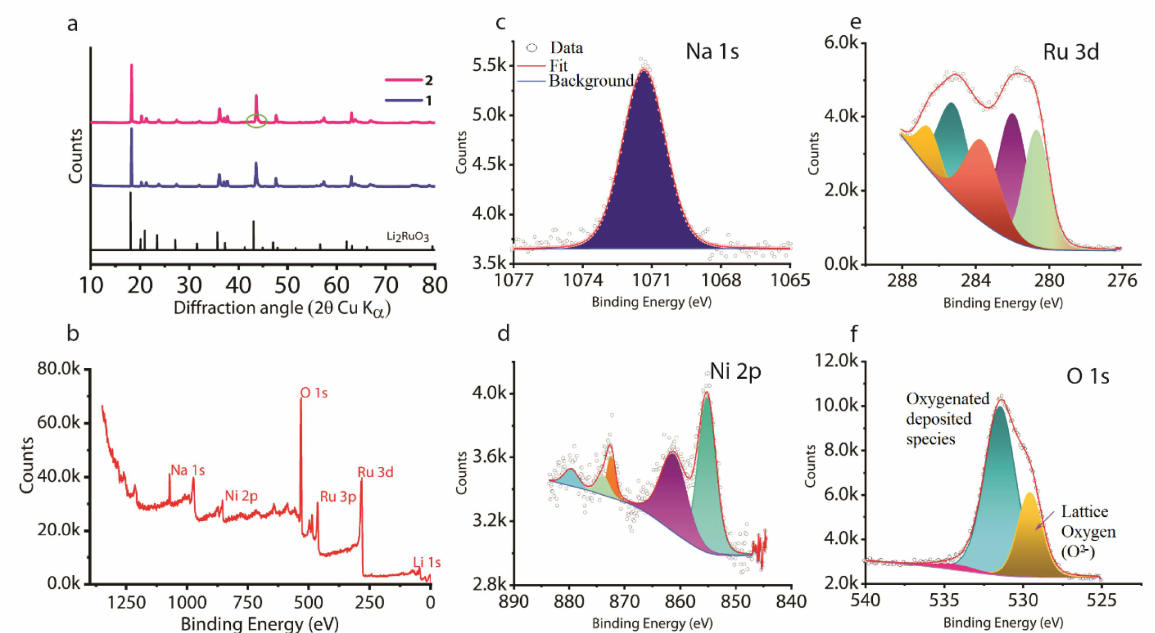
(Figure 1f), fitted with three components apportioned as oxidative oxygen (O 22 − /O − : BE ~529.58 eV), carbonate/hydroxides/oxyhydroxides species (CO 32 − /OH − /OOH: BE ~531.48 eV), and absorbed water (H 2 O: BE ~534.88 eV) suggest a relatively more significant number of O 22 − /O − species in 2 . This indicates a surplus amount of surface oxygen vacancies [30] compared to 1 (Figure S1c) with hydroxides (BE ~531.7 eV) and oxygen species (BE ~533.4 eV). Firstly, Na doping has significantly modified the electronic structure, which agrees with previous reports on layered cathodes [6,8]. Secondly, the excess of O 22 − /O − species on the surface of 2 is beneficial for catalyzing OER reactions in alkaline media [31,32].